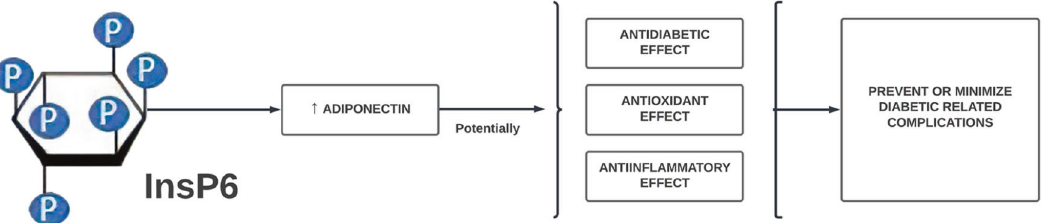
Fig. 4 InsP6 supplementation increase adiponectin levels in patients living with T2DM. Thus, could potentially improve glycemic control, decrease in fl ammation and reduce oxidation potentially reducing or minimizing diabetic-related